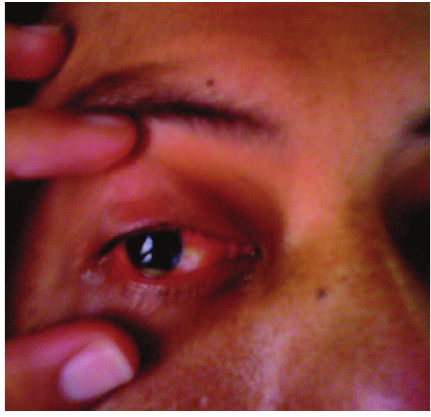
Figure 2: Hypopyon in right